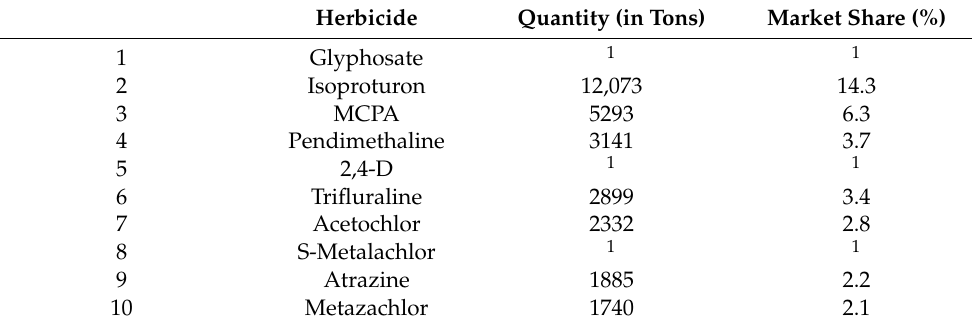
Table 2. Top 10 most used herbicides in the EU in 2003.